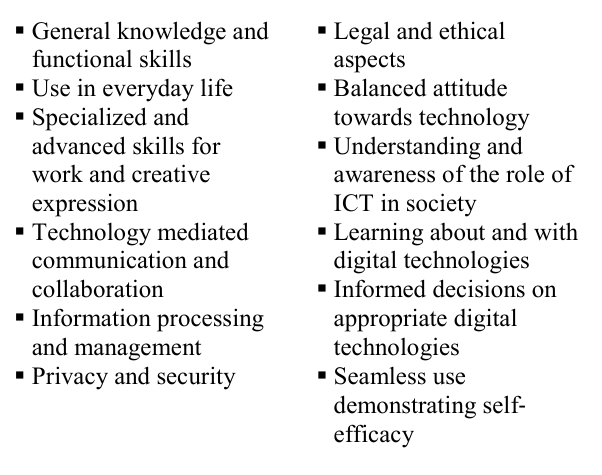
Table 1. DIGCOMP Framework Competence Areas (Early